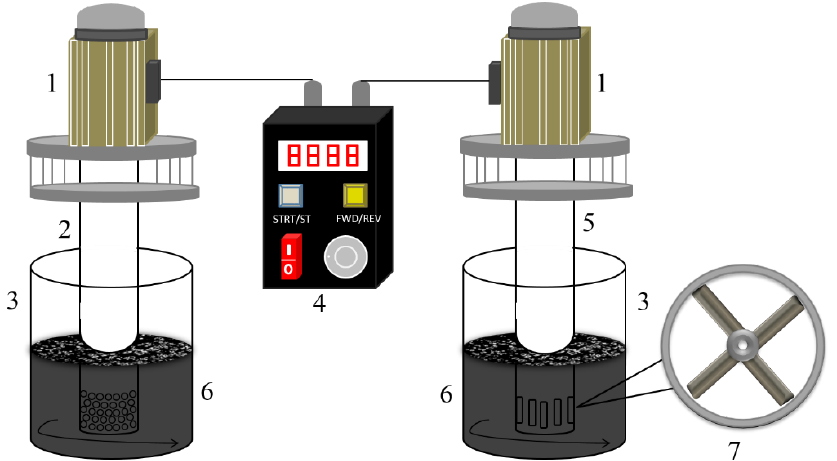
Figure 1. Diagram of a high-speed stirring cleaning device: 1—brushless motor; 2—Rotor-C; 3—mixing tank; 4—motor controller; 5—Rotor-V; 6—oily sludge; 7—impeller.